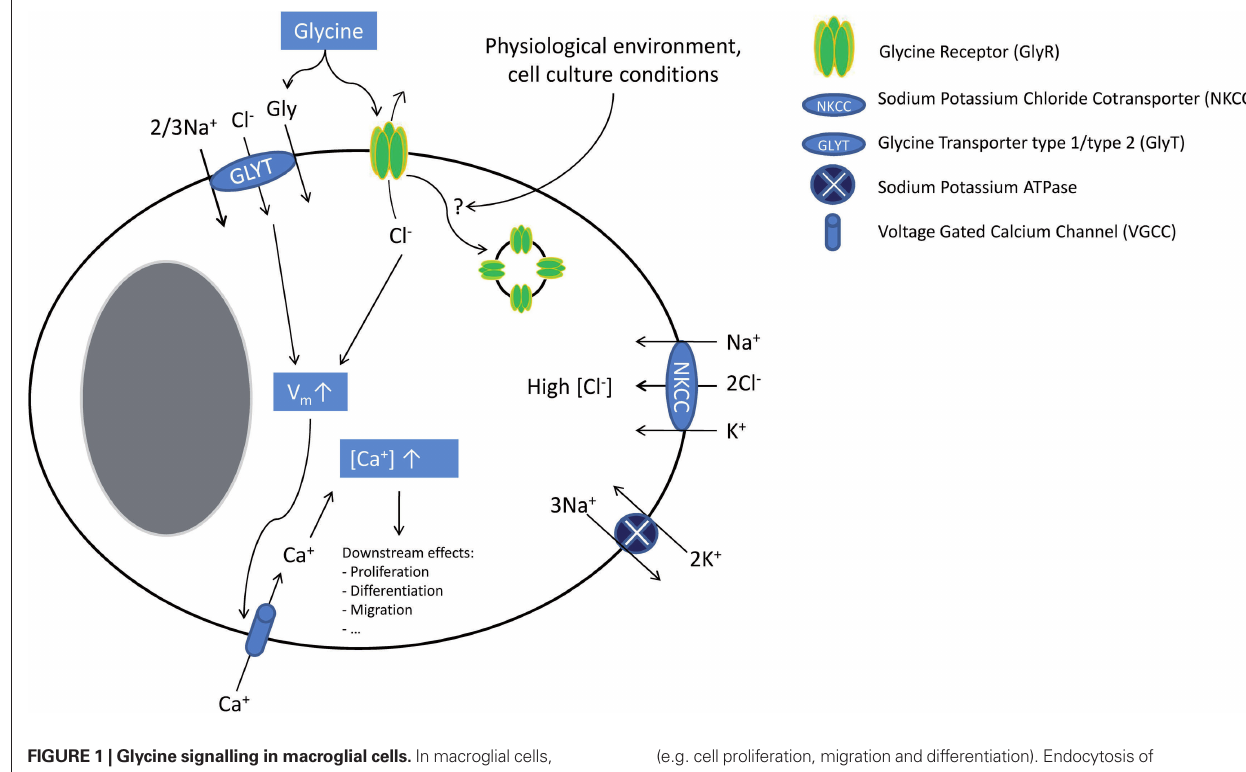
FIGURE 1 | Glycine signalling in macroglial cells. In macroglial cells, NKCC activity leads to intracellular chloride accumulation. Upon ligand binding, GlyR activation causes chloride effl ux leading to cellular depolarization (which is further enhanced by electrogenic GlyT activity). This depolarization then activates VGCC. The resulting calcium infl ux increases the intracellular calcium concentration inducing several downstream effects